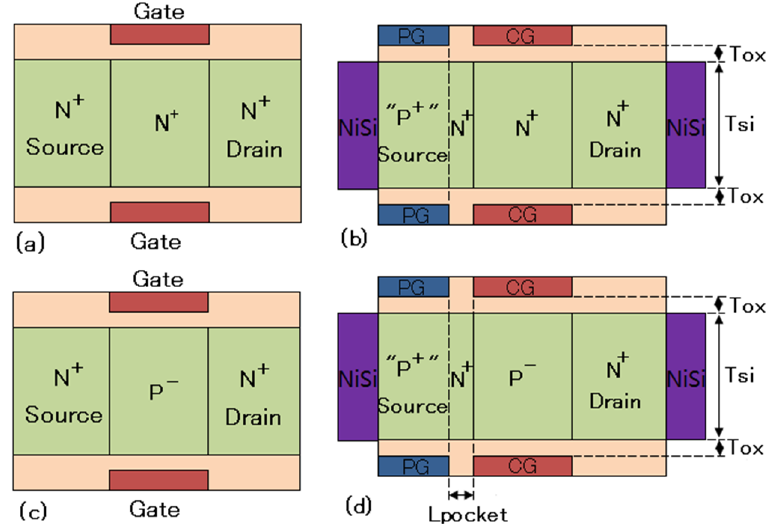
Figure 1. Cross-sectional views of ( a ) Beginning JL FET structure to realize conventional electrically doped TFET (ED-TFET), ( b ) Conventional ED-TFET [19], ( c ) Beginning MOSFET structure to realize the in-built N + pocket ED-TFET, ( d ) In-built N + pocket ED-TFET. JL FET, junctionless field-effect transistor; ED-TFET, electrically doped tunnel field-effect transistor; MOSFET, metal-oxide-semiconductor field-effect transistor. Table 1. Parameters used for device simulation.